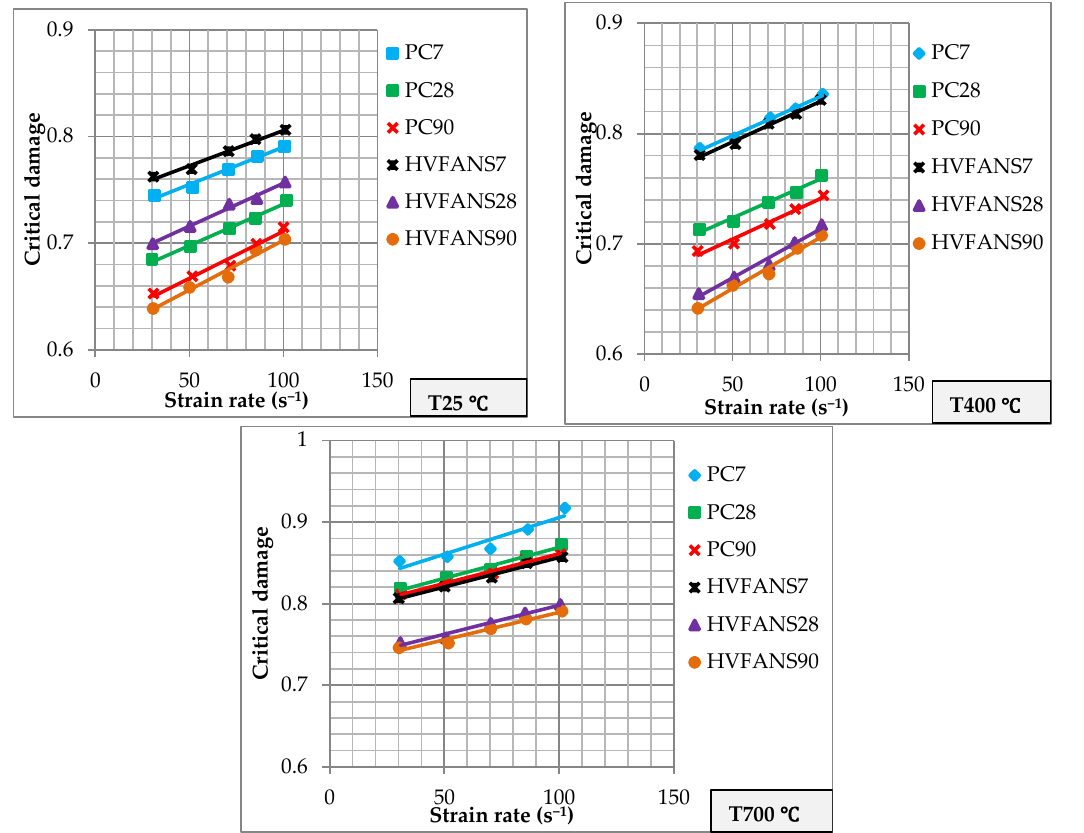
Figure 9. Effect of curing age on the critical damage of concrete specimens at different temperatures Figure 9. E ff ect of curing age on the critical damage of concrete specimens at di ff erent temperatures and strain rates. and strain